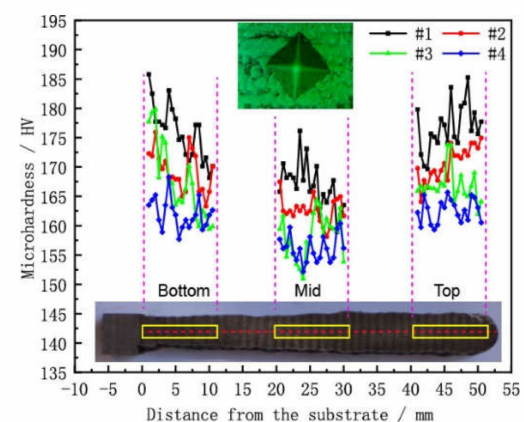
Figure 9. Microhardness distribution of di ff erent parts of as-deposited samples.